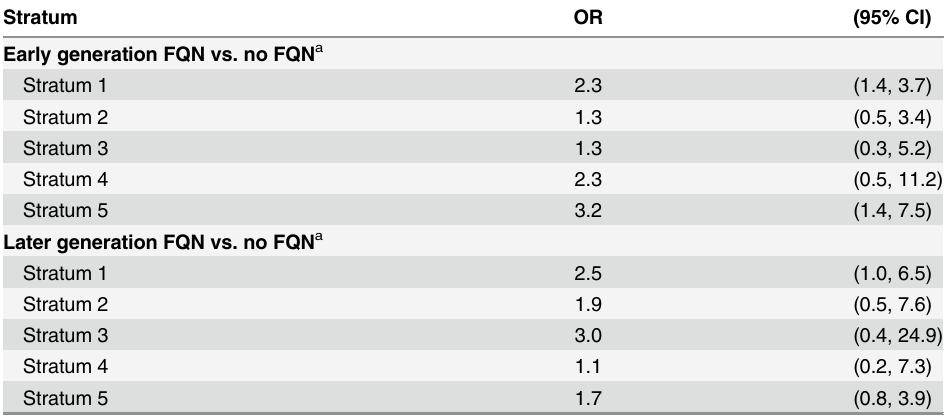
Table 10. Stratification by propensity score quintiles, using propensity score as a model covariate. Stratum OR (95%